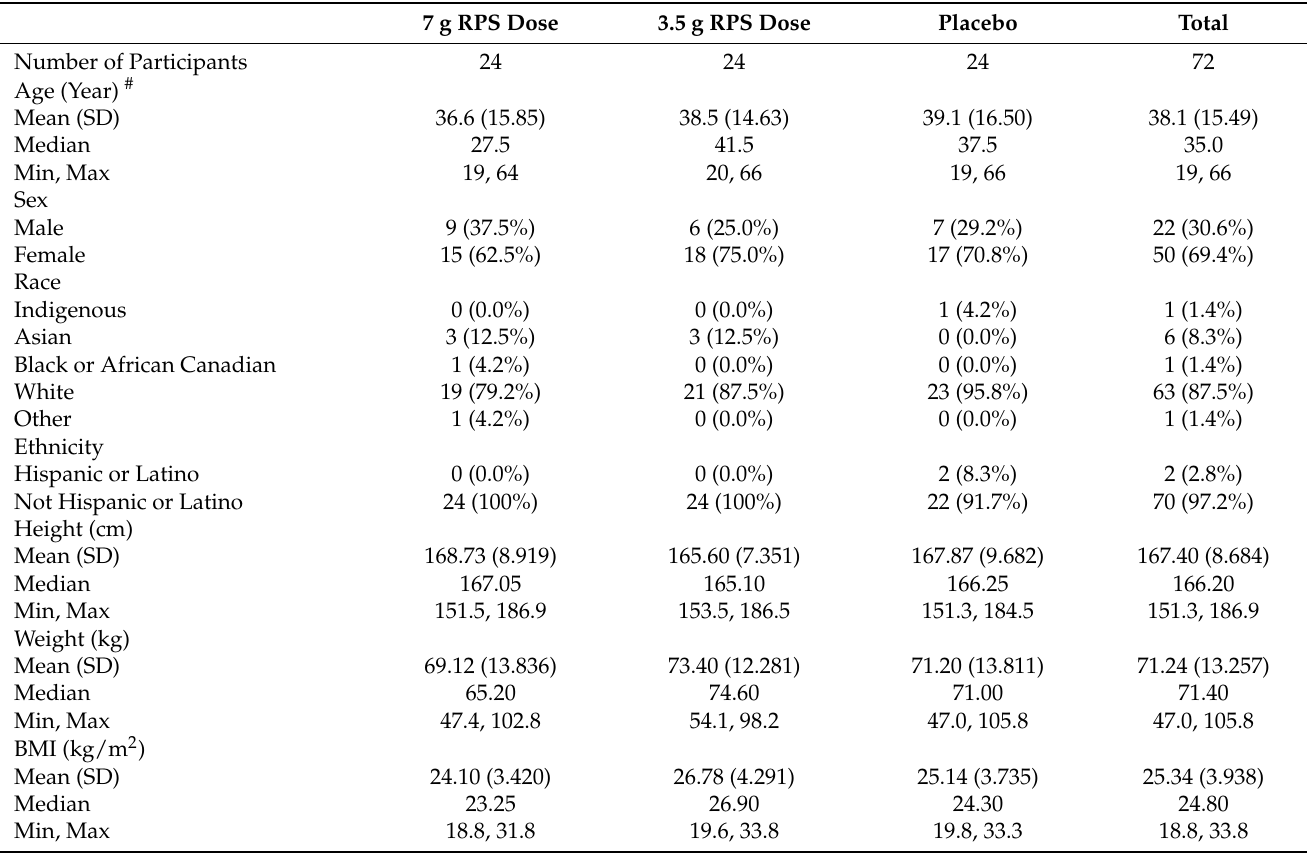
Table 1. Baseline demographic data for the FAS